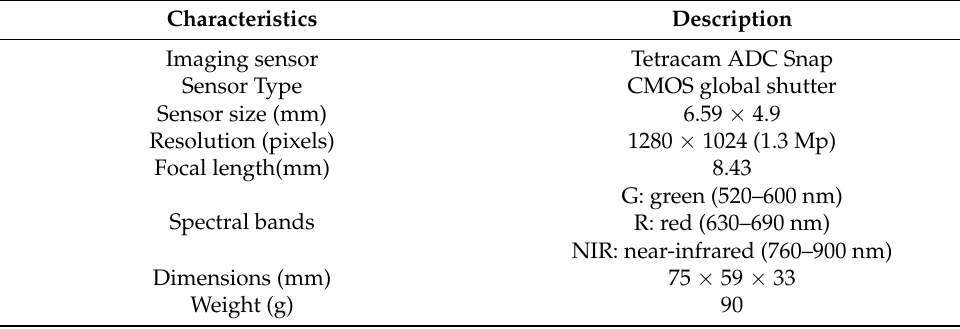
Table 1. UAV camera specifications.